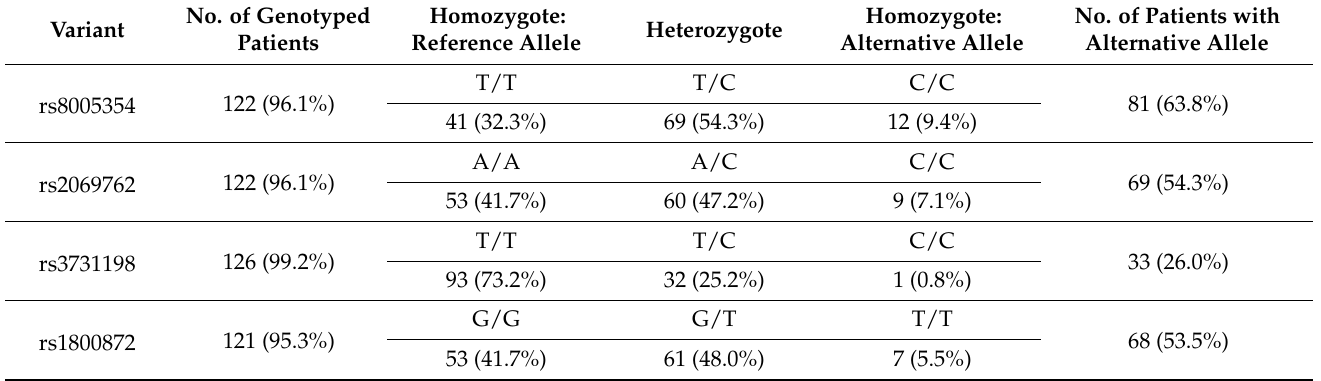
Table 5. Genetic variants assessed in NET